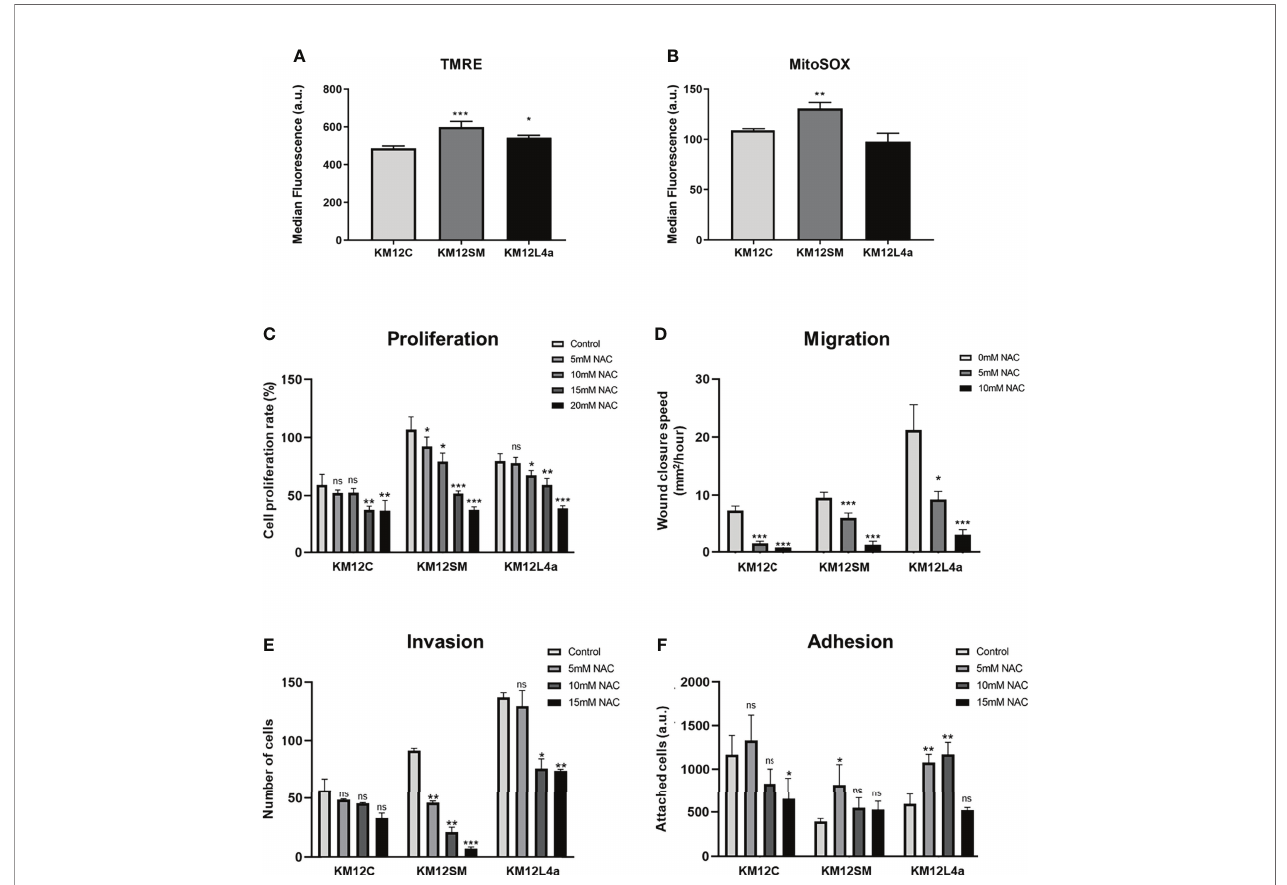
FIGURE 3 | Reactive oxygen species effects on CRC cells. (A, B) Quanti fi cation by FACS analysis of Y m at mitochondria and ROS species. Statistical analysis is referred to the comparisons with KM12C cells. (A) A TMRM probe was used to quantify the mitochondrial membrane potential ( Y m). (B) A MitoSOX-Red probe was used to determine the levels of mitochondrial superoxide anions (SO*). Analysis of the effect of NAC (0 – 20 mM) on proliferation (C) , migration (D) , invasion (E) , and adhesion (F) ability of metastatic and non-metastatic KM12 CRC cells. Wound closure speed is referred to wound size differences between 0 and 62 h of each experiment. Metastatic CRC cells were more dependent on the high levels of ROS to maintain their properties, with KM12SM cells being the most dependent of ROS. (C – F) Statistical analysis is referred to the cells without NAC treatment. * p value < 0.05; ** p value < 0.01; *** p value <